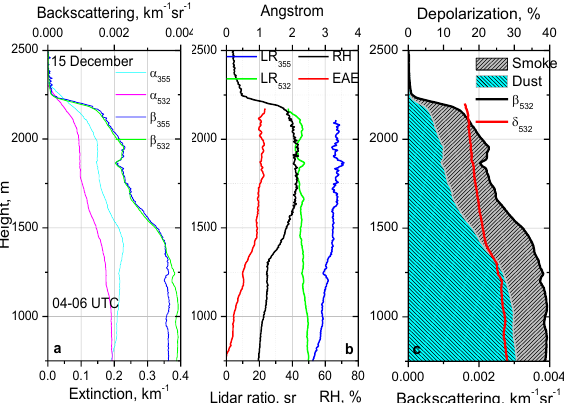
Figure 2. Vertical profiles of (a,b) the lidar ratios at 355 nm and 352 nm, (c) the particle depolarization ratio  532 and (d) extinction Angstrom exponent at 355- 532 nm for seven temporal intervals during 1-4 April period.